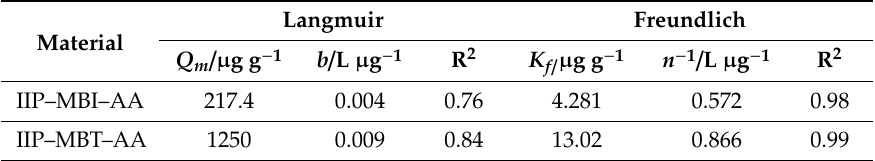
Table 3. Langmuir and Freundlich isotherm